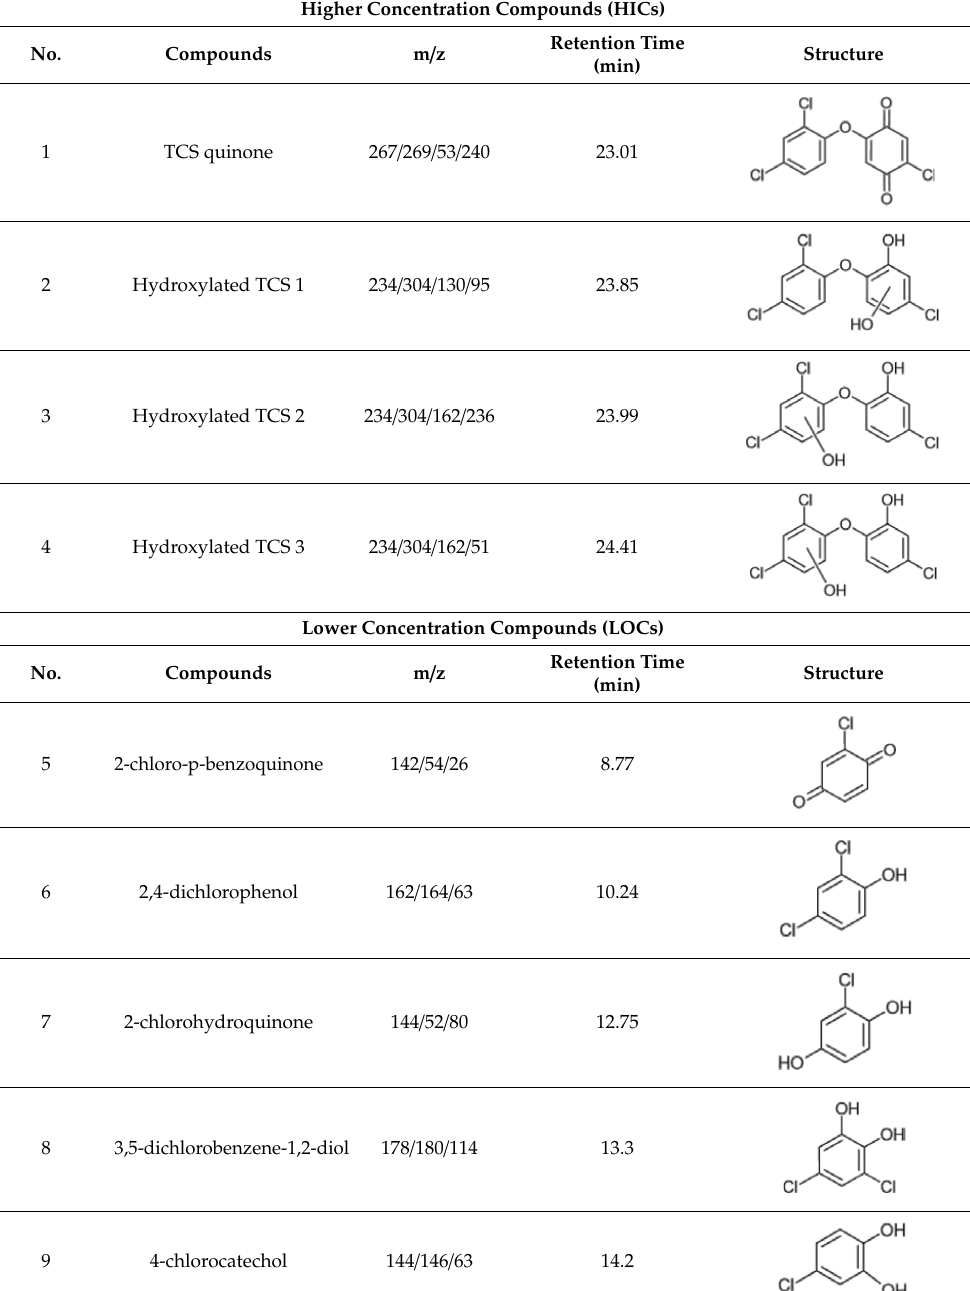
Table 1. Summary of the identified higher concentration compounds (HICs) and lower concentration compounds (LOCs).